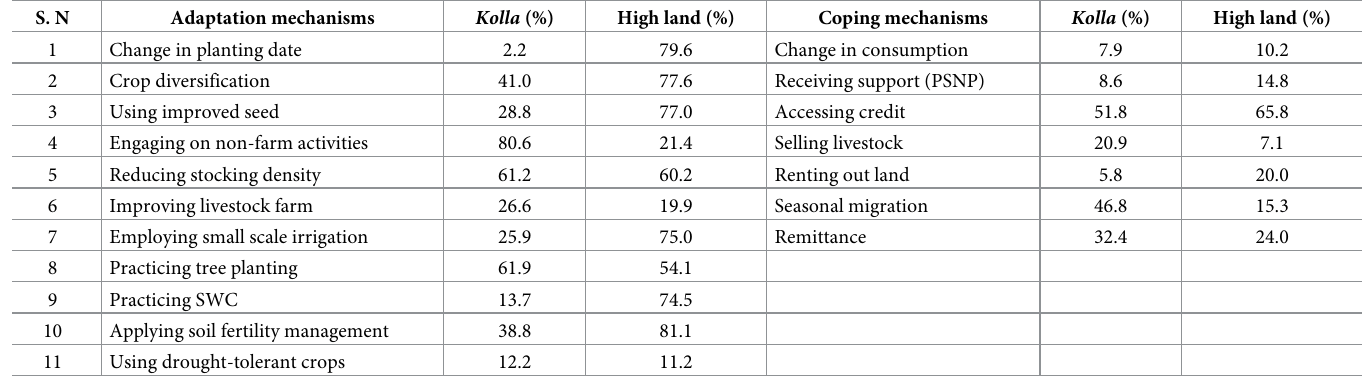
Table 1. Extents of farmers’ adoptions of adaptation and coping strategies across case studies. S.